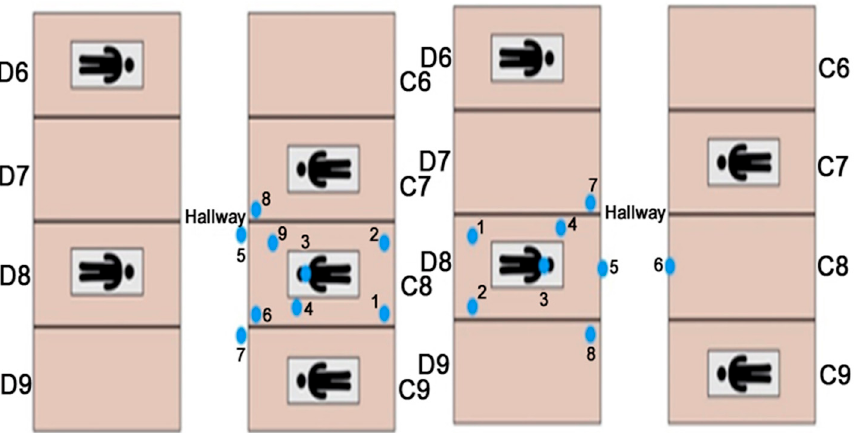
Figure 6. Positions of the sensors’ network were tested in a dental operatory consisting of 16 individual bays. Two bays, C8 and D8, were equipped with the sensors.